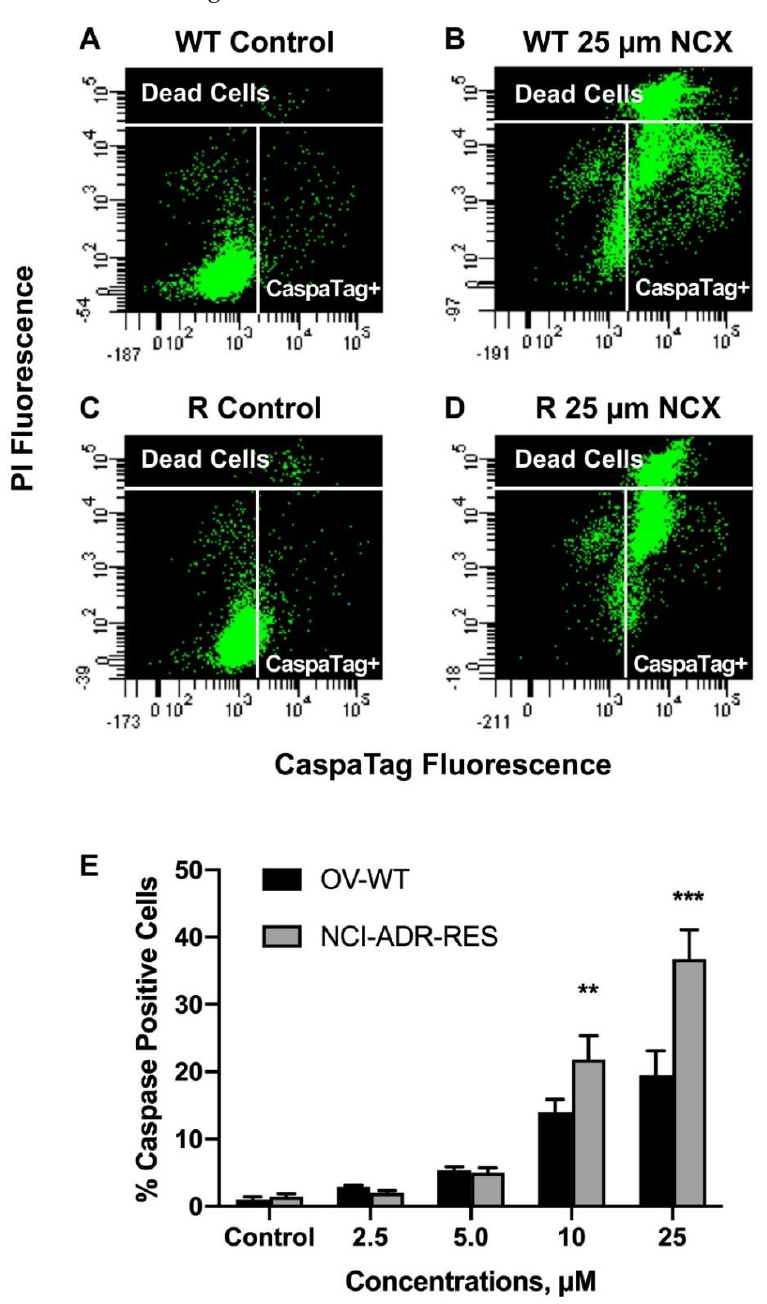
Figure 6. Detection of CaspaTag positive cells ( A , B ) OVCAR-8 and ( C , D ) in NCI/ADR-RES cells and with different concentrations of NCX4040 for 24 h ( E ). Representative plots ( A – D ) are shown here. ** and *** p -values, <0.005, and <0.001, respectively, compared to concentration-matched treatment.